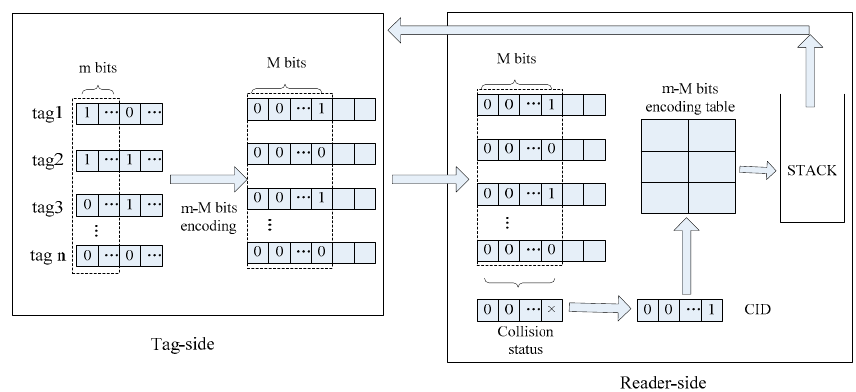
Figure 5. Identification process based on coding.